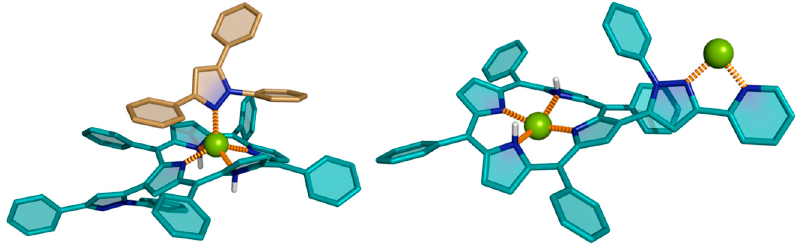
Figure 10. Views of the 1:2 (M/L) complex involving Zn 2+ and 30a and the 2:1 (M/L) complex involving 30e , as calculated at the B3LYP/LanL2DZ level (adapted from [112]).